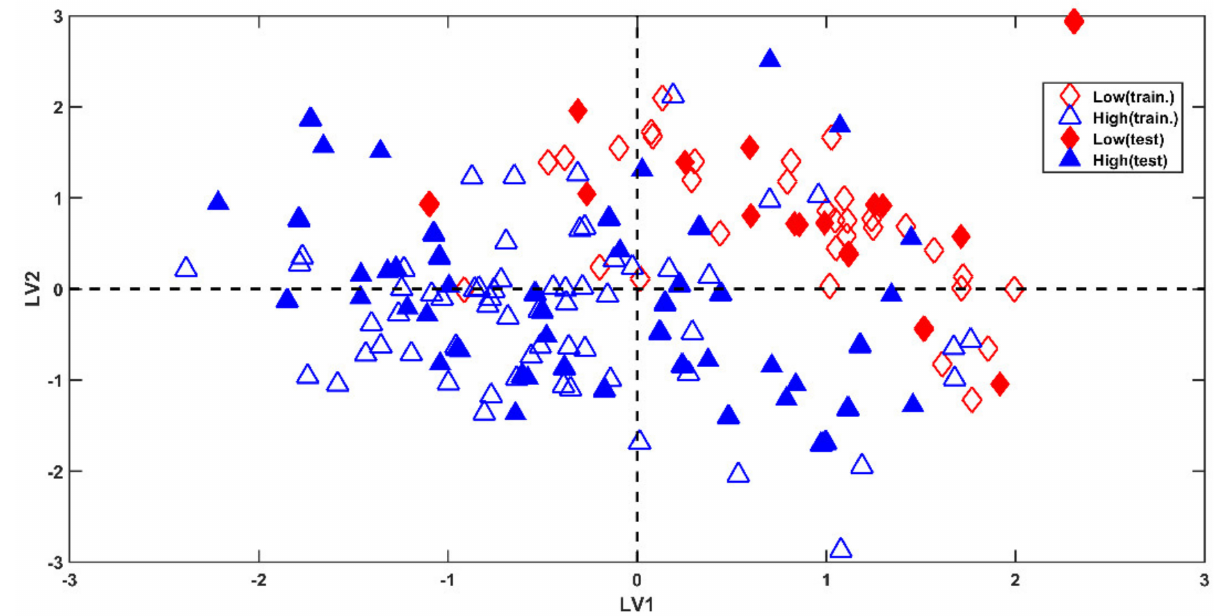
Figure 2. PLS-DA: model on the IP-based categorization. Projection of the training and test molecules onto the first two latent